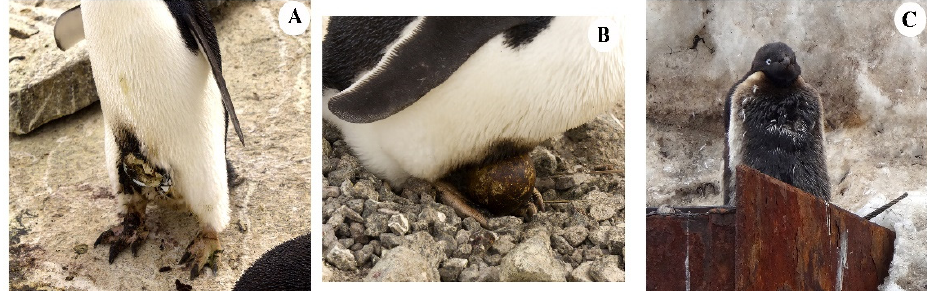
Figure 2. Oil contamination of Adélie Penguins ( Pygoscelis adeliae ) in the Haswell archipelago area: ( A ) Shells from a broken egg adhering to the oil-stained lower body of an adult (Stroiteley Island, 17 December 2012); ( B ) The brooding spot of an adult and the surface of the egg shell stained with oil (Stroiteley Island, 17 December 2012); ( C ) A molting adult soiled with oil (Mirny Station, Cape Mabus, 20 February 2015). Photo by the